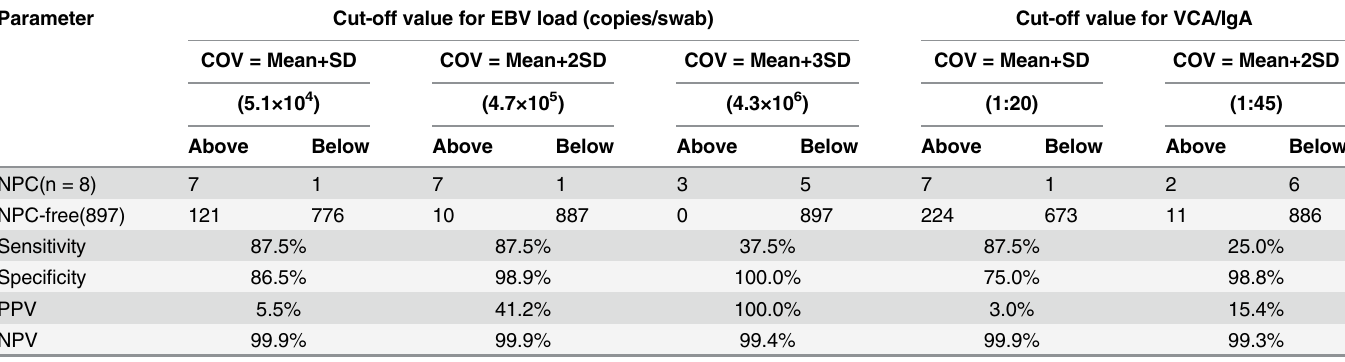
Table 6. Cut-off values for EBV load and VCA/IgA titers.